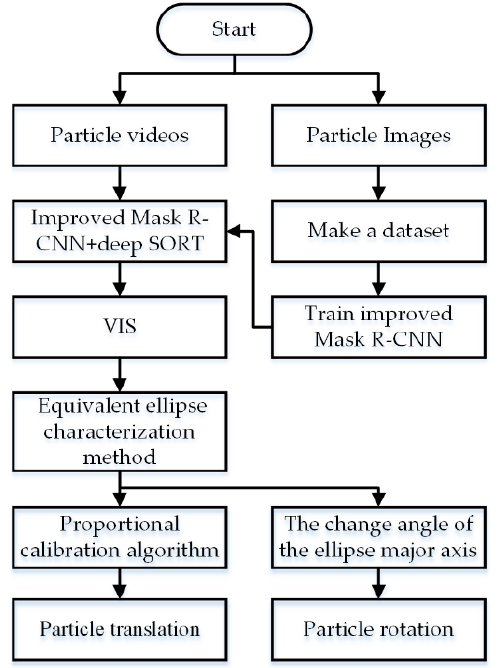
Figure 1. Method framework.